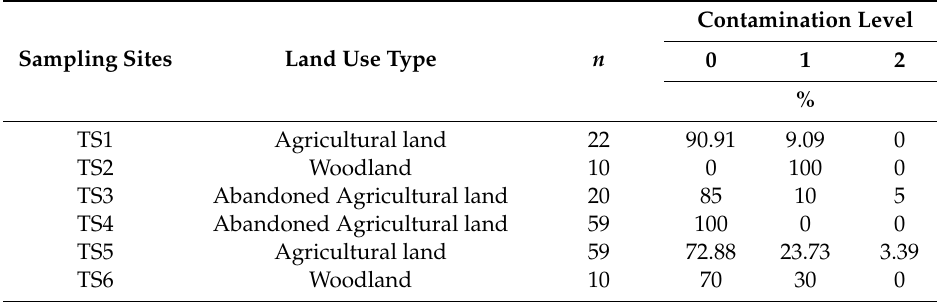
Table 6. The ratio of mercury contamination level.